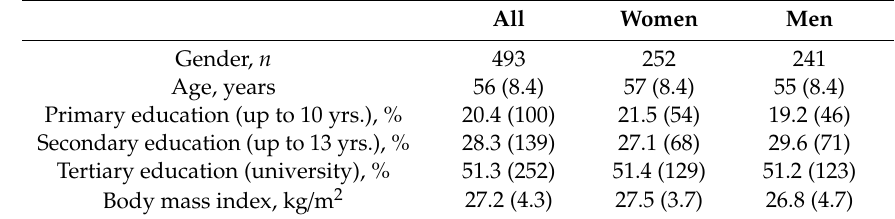
Values are mean (standard deviations) or percentages (numbers). yrs,